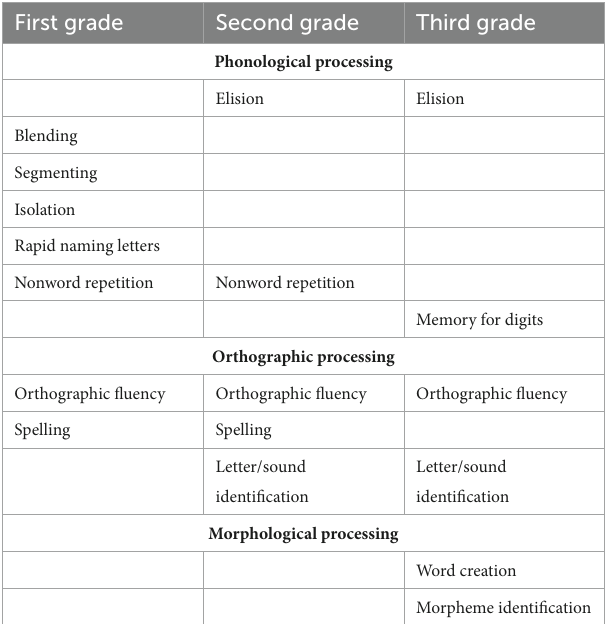
TABLE 7 Significant predictors of word reading accuracy by grade